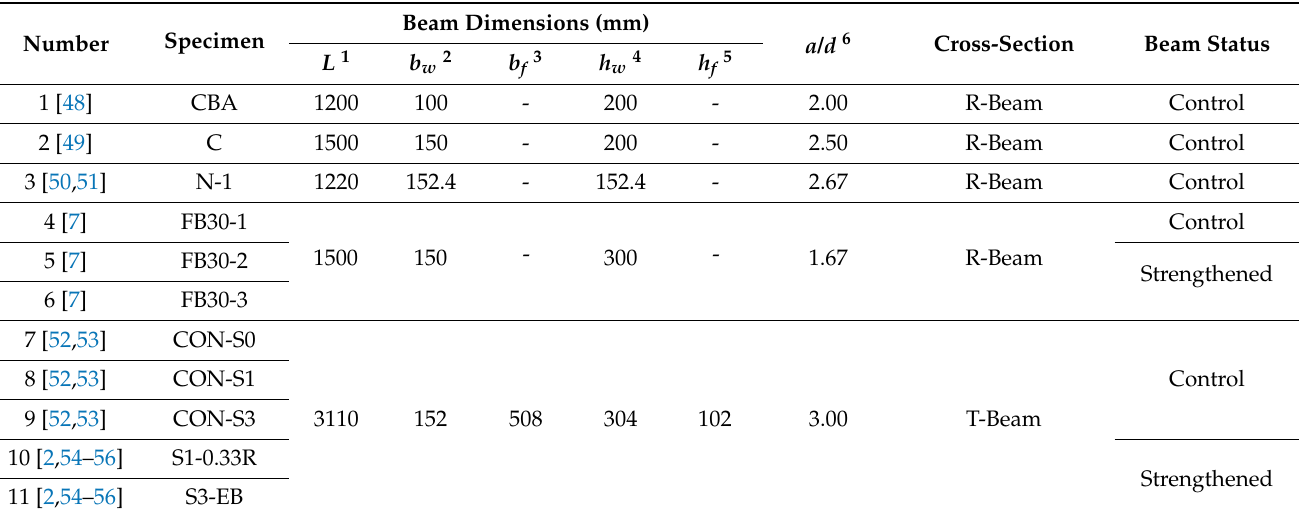
Table 2. Specimens Geometrical Characteristics.